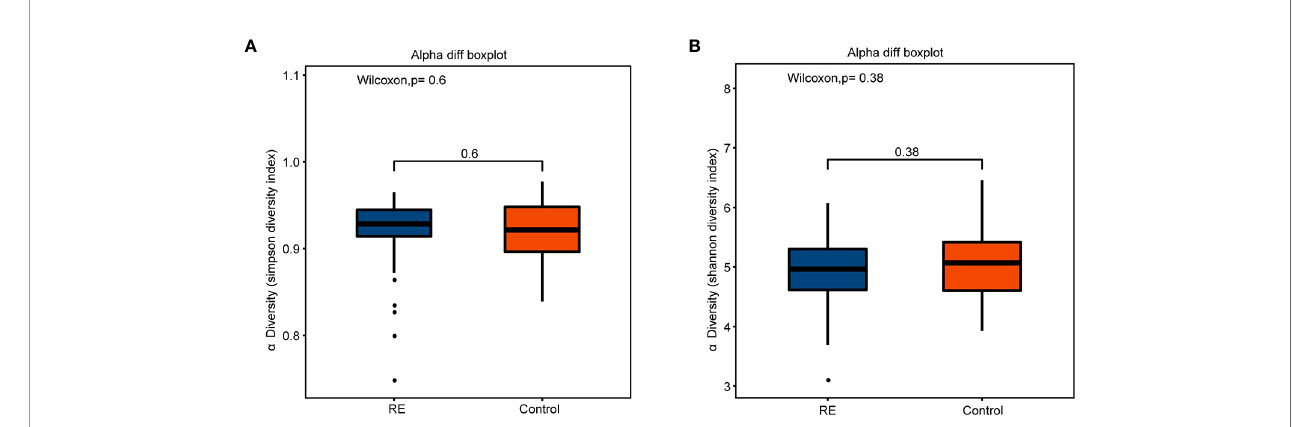
FIGURE 1 | Comparisons of alpha diversity indices between Re fl ux Esophagitis (RE) and healthy controls. There was no great signi fi cance between RE and healthy controls in Simpson diversity index ( A , p =0.60) and Shannon diversity index ( B , p